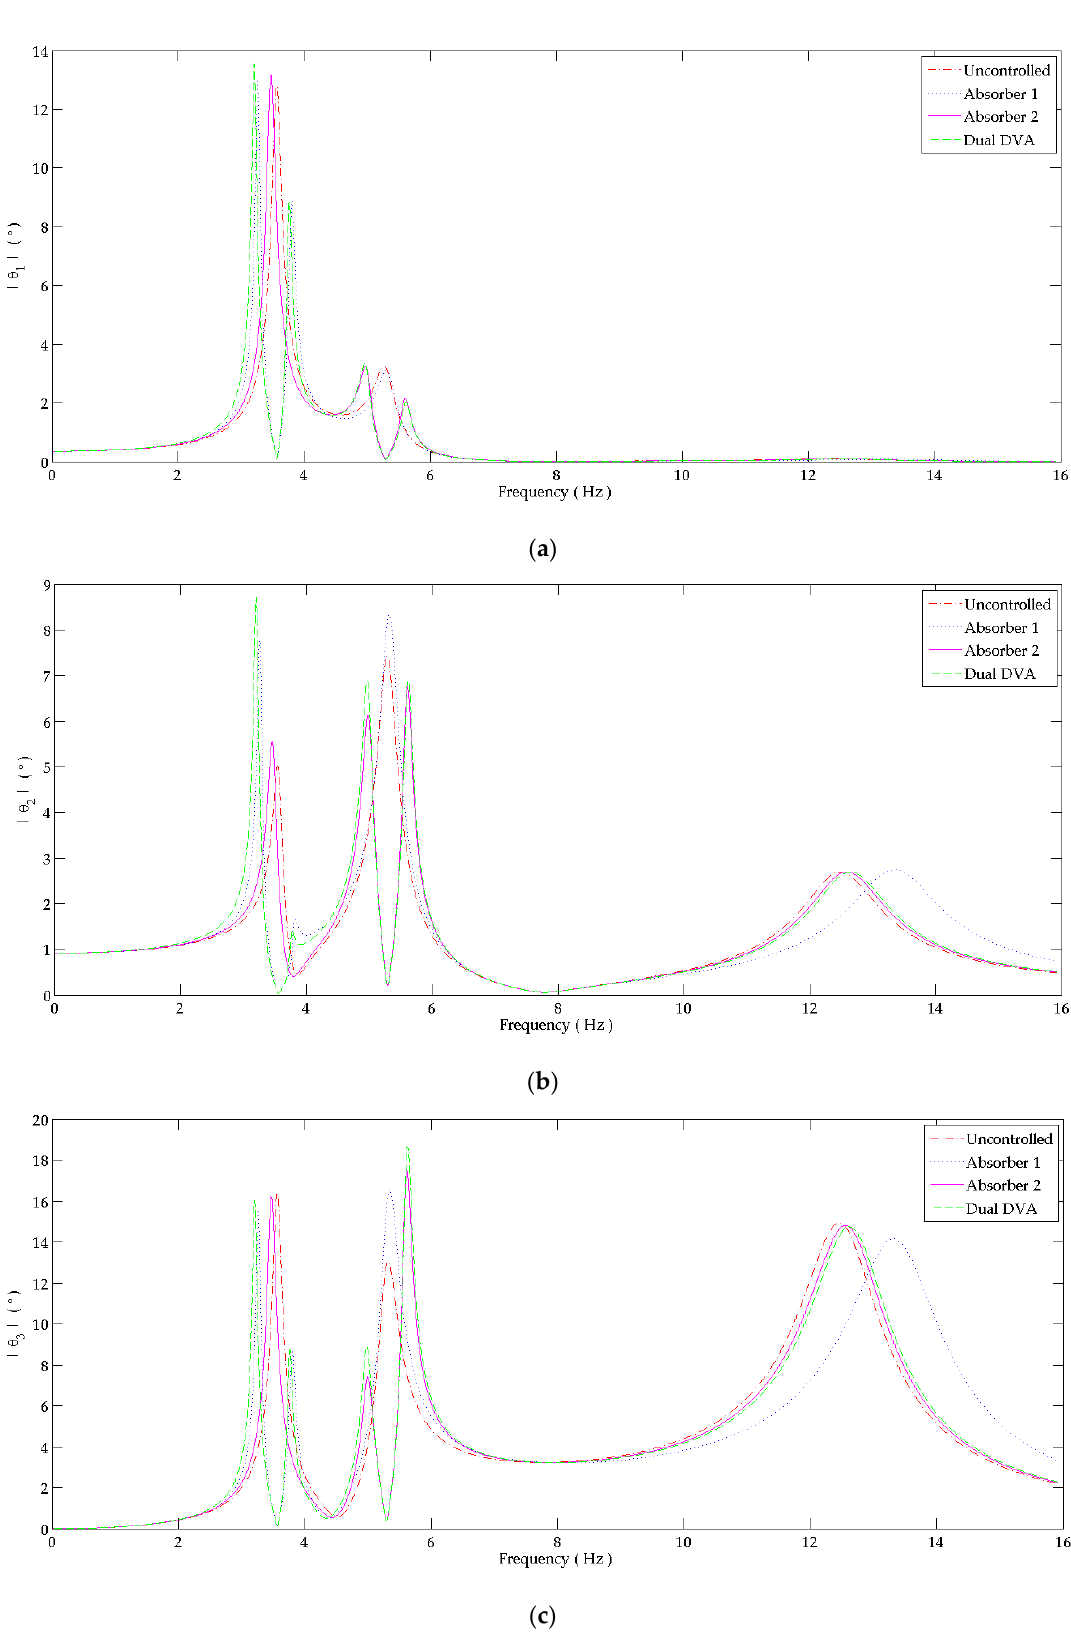
Figure 6. Response in the frequency domain at: ( a ) Shoulder joint; ( b ) Elbow joint; ( c ) Wrist joint. The behavior at each joint is studied when attaching to the forearm: “absorber 1” alone, “absorber 2” alone and the ”dual DVA” tuned at wrist joint’s responses. It is compared to the response of the uncontrolled system.